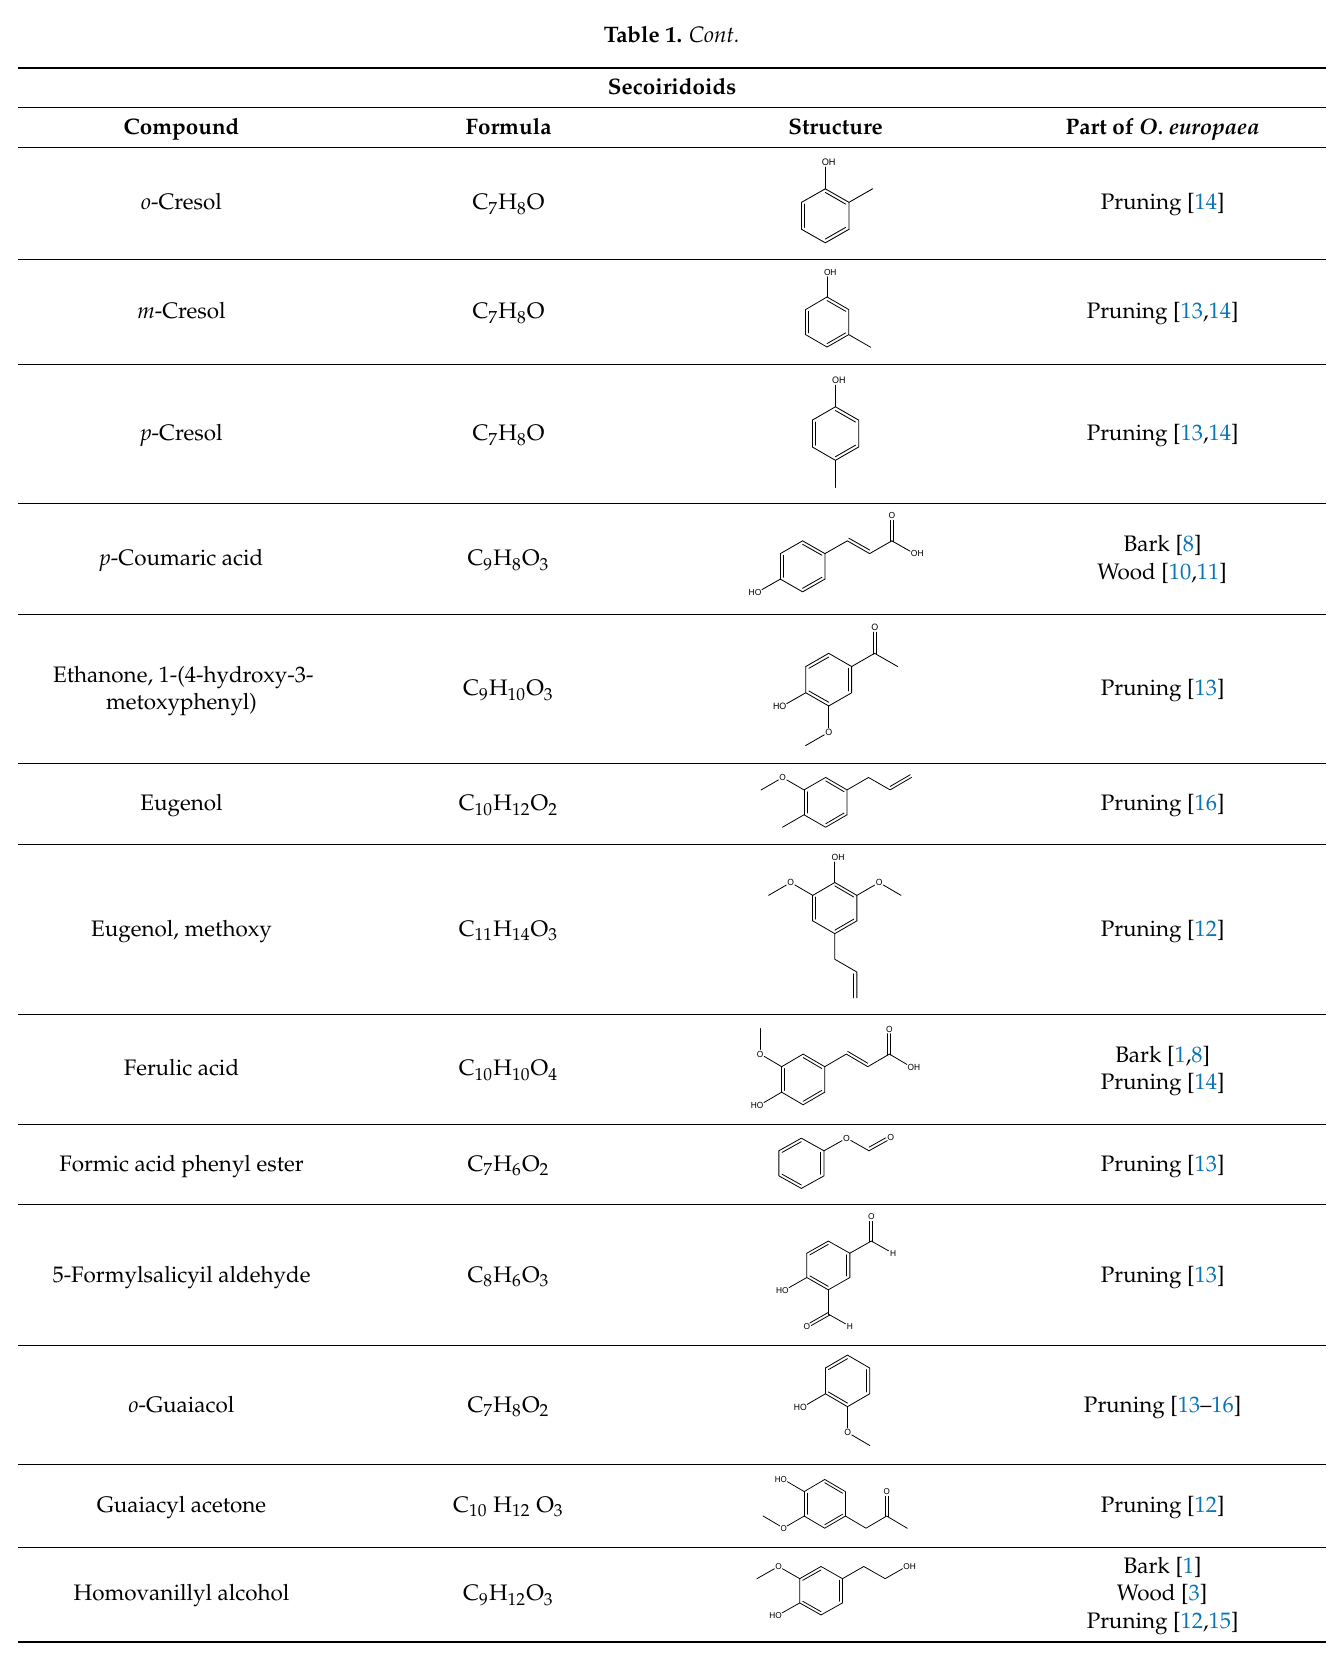
Table 1. Cont. Secoiridoids